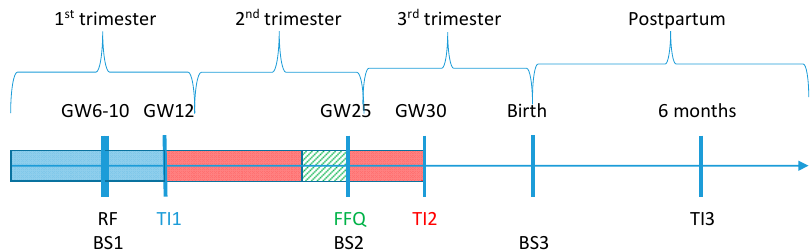
Figure 1. Timeline for data collection in Danish National Birth Cohort (DNBC). Colored boxes show the retrospective recall period for reported dietary intake. BS: blood sample; FFQ: food frequency questionnaire; GW: gestational week; RF: recruitment form; TI: telephone interview.